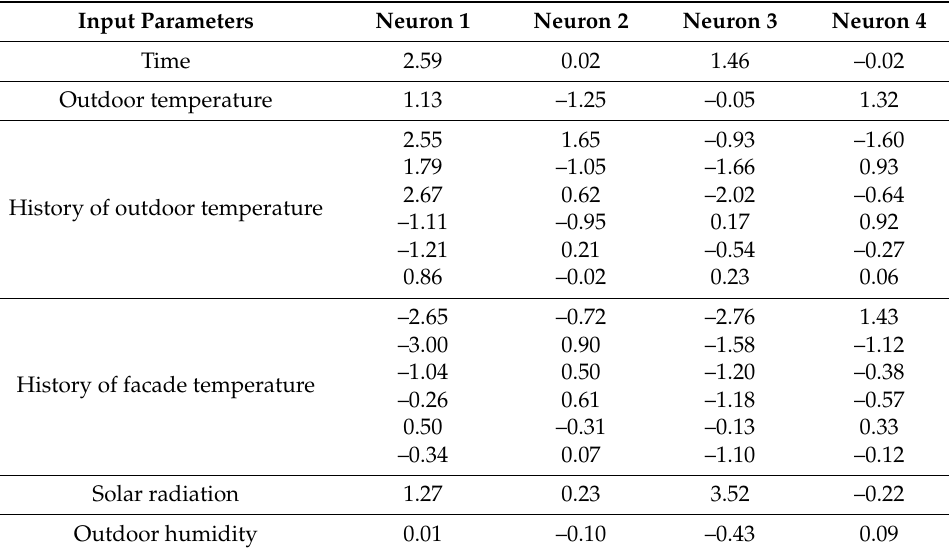
Figure 2. Artificial Neural Network (ANN) optimal architecture. Table 2. Weight of neurons’